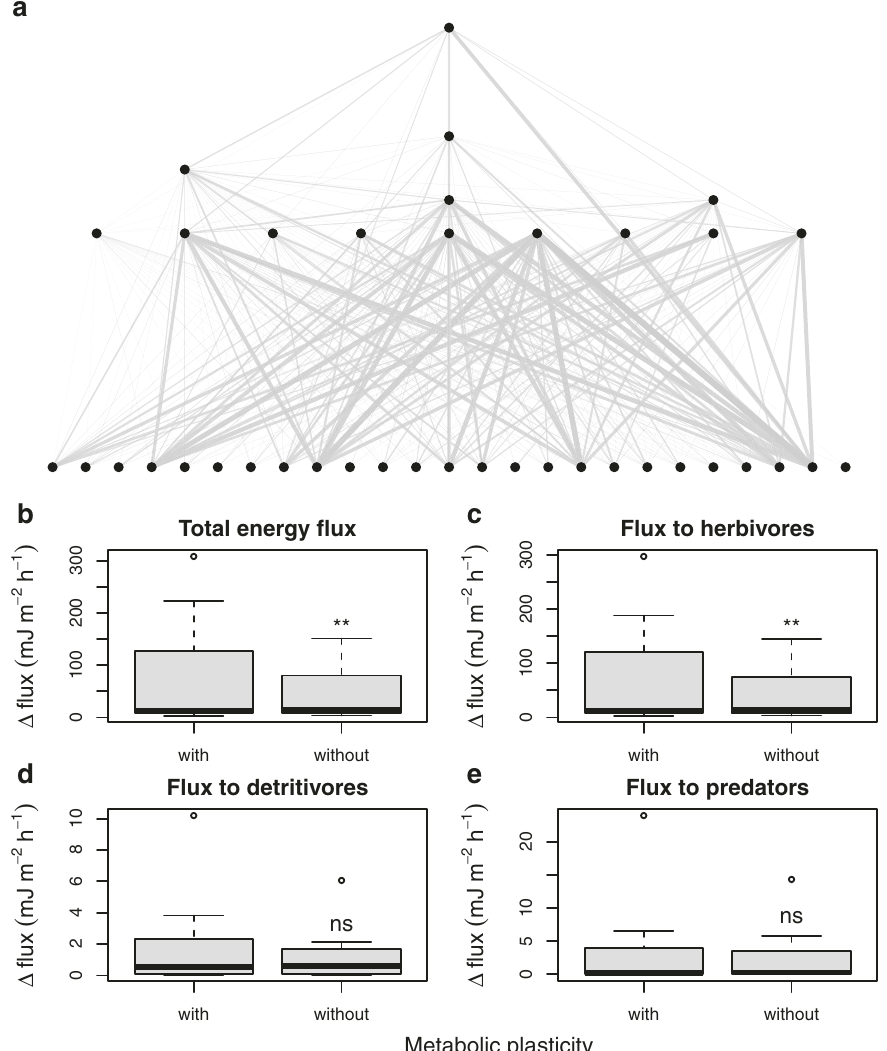
Fig. 2 Effect of metabolic plasticity on the predicted impact of global warming on ecosystem-wide energy fl uxes. a Visualisation of changes in modelled energy fl uxes through a food web in the study system after a simulated + 2 °C of warming. Thicker lines (trophic links) between species populations (nodes) indicate a greater predicted increase in energy fl ux using the model with metabolic plasticity compared to the one without. b Using empirical data from our 14 study sites, the model with metabolic plasticity predicts a signi fi cantly greater increase in total energy fl ux through the networks following + 2 °C of warming than the model without metabolic plasticity. This increase is driven by ( c ) fl ux to herbivores, with no signi fi cant contributions of increasing fl ux to ( d ) detritivores or ( e ) predators. Tukey box and whisker plots are shown, with the thick black line as the median, limits as the 1st and 3rd quartiles, whiskers as 1.5 times the interquartile range, and outliers as individual points. One-sided paired Wilcoxon tests were performed on the data in panels ( b – e ); n = 14 for every individual boxplot; ** p ≤ 0.01; ns no signi fi cant difference. Source data are provided as a Source Data fi